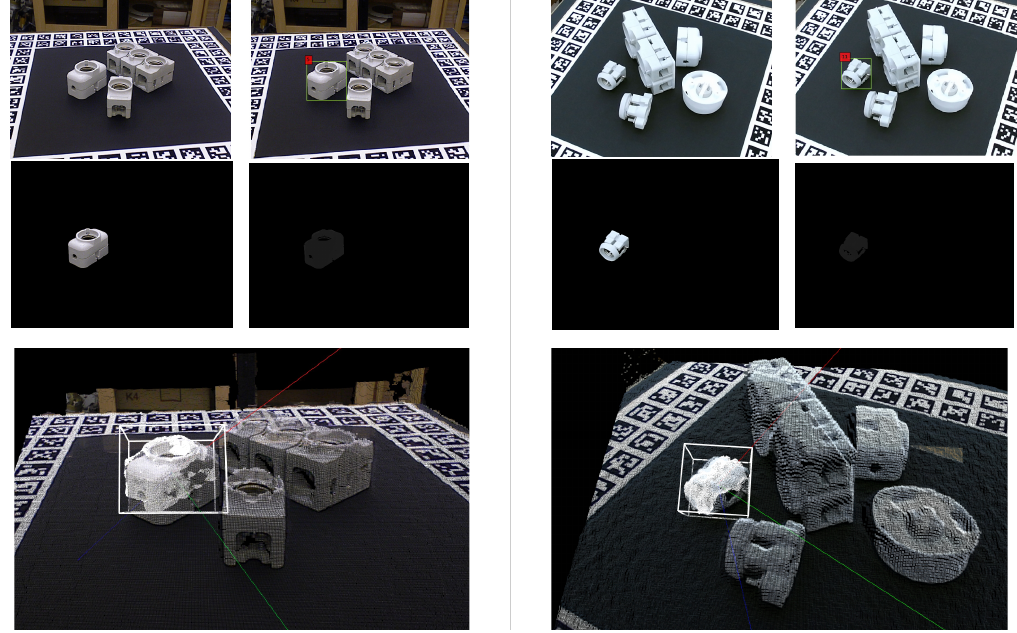
Figure 15. Left : Top row shows RGB input image and the predicted bounding box for object 5 Scene 2, middle row shows segmented region on RGB and Depth image, and bottom row shows the final predicted pose in the point cloud scene of the input RGB-D image. Right : Top row shows RGB input image and the predicted bounding box for object 11 Scene 6, middle row shows segmented region on RGB and Depth image, and bottom row shows the final predicted pose in the point cloud scene of the input RGB-D